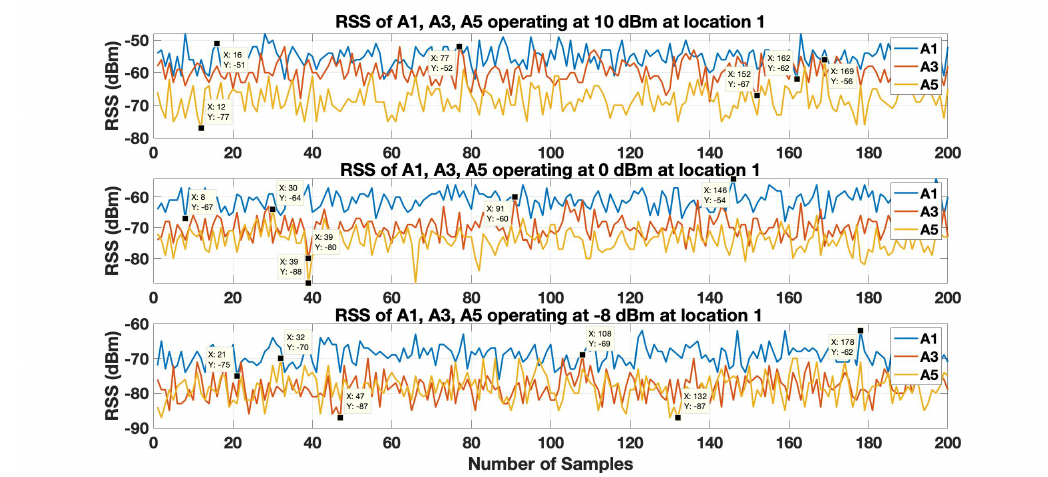
Figure 8. RSS of anchors A 1 , A 3 , and A 5 operating at 10 dBm, 0 dBm and − 8 dBm at Location 1 in Environment 1.